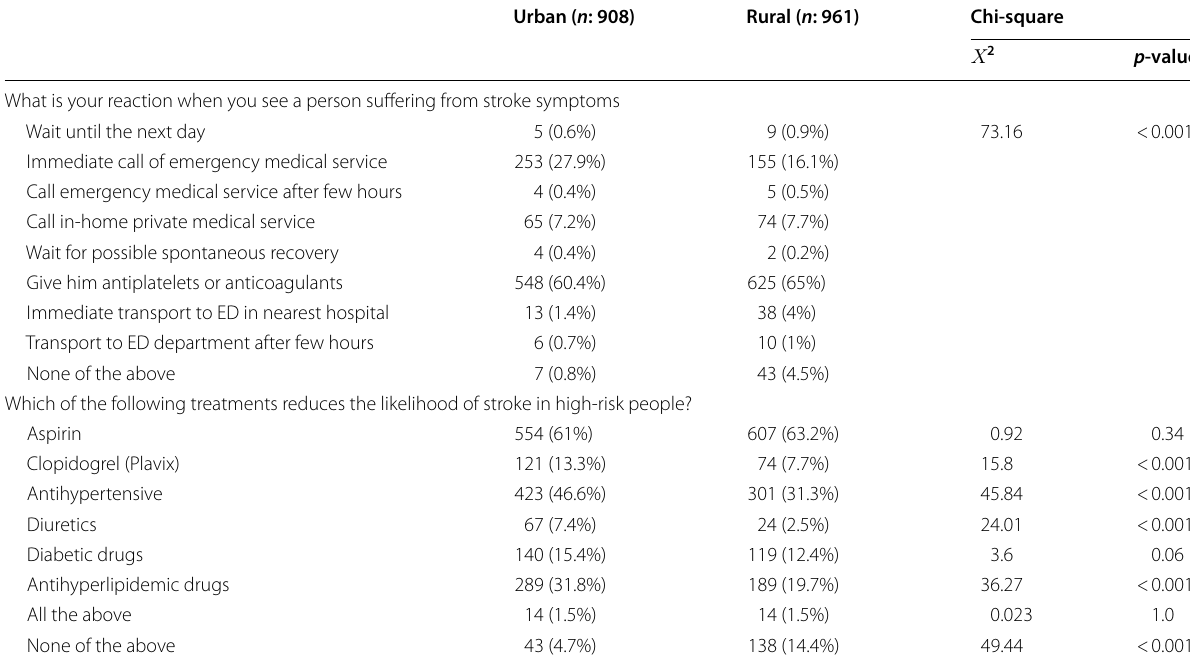
Table 4 Uni- and multi-variate regression analysis between urban and rural participants’ groups regarding stroke knowledge and awareness